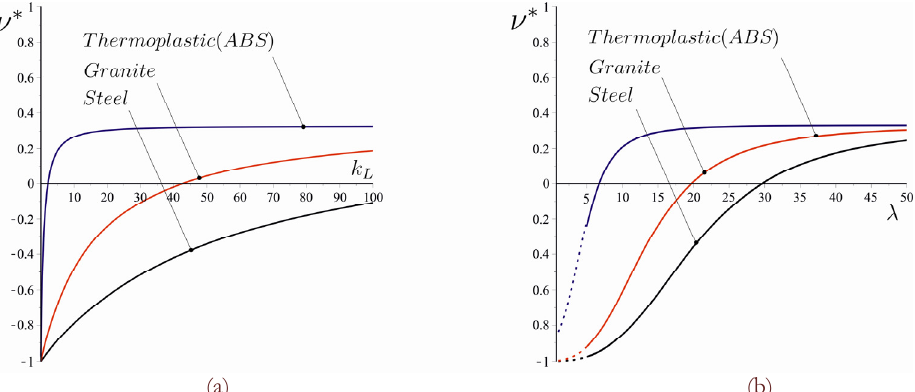
Figure 6: Effective Poisson’s ratio ν * for three different materials in the case of longitudinal springs. (a) Poisson’s ratio as a function of the stiffness k L . (b) Poisson’s ratio as a function of the slenderness λ =p/s.